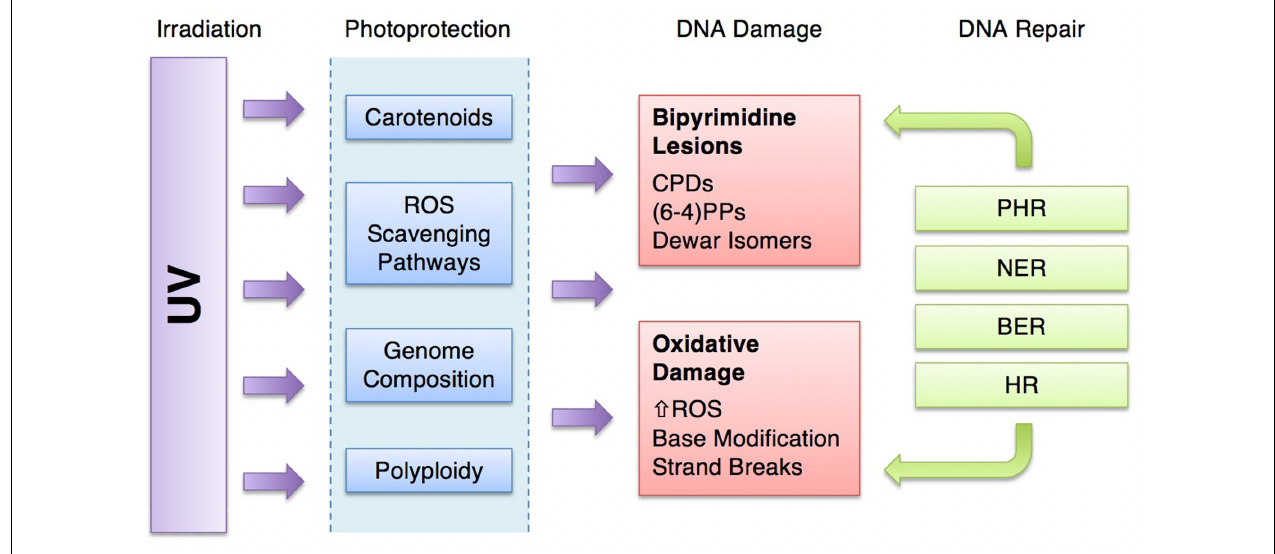
FIGURE 6 | Ultraviolet-resistance strategies of halophilic archaea. UV irradiation is attenuated by photoprotective mechanisms, lessening the damage to DNA. The damage that does result may be repaired by a suite of DNA repair systems. [UV, ultraviolet radiation; ROS, reactive oxygen species; CPDs, cyclobutane pyrimidine dimers; (6-4)PP, pyrimidine (6-4) pyrimidone photoproducts; PHR, photoreactivation; NER, nucleotide excision repair; BER, base excision repair; HR, homologous